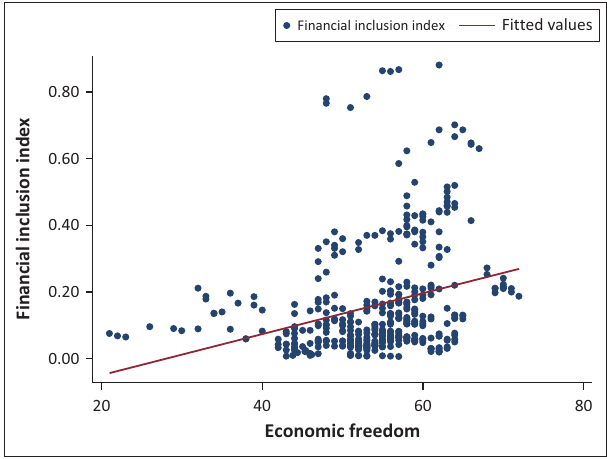
FIGURE 4: Economic freedom.